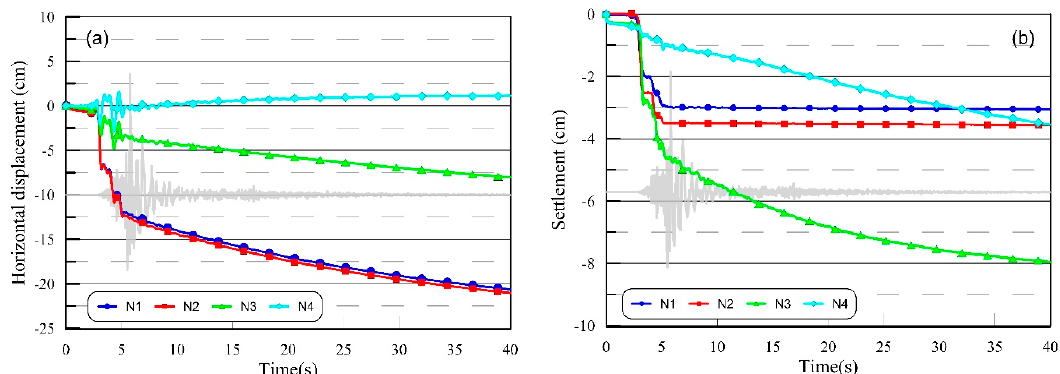
Figure 21. ( a ) Horizontal displacement (positive values are to the right side, and negative values are to the left side), and ( b ) settlement of the observed nodes in the analysis.